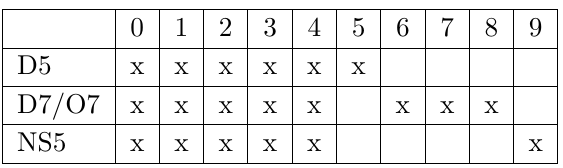
Table 2 . Brane intersection associated to the Abelian T-dual of BO. In the near brane limit x 6 and x 9 mix [11], to produce D7/O7 branes spanned on AdS 6 (cid:2) S 2 and NS5-branes spanned on AdS 6 , consistently with the isometries of the background. These branes are located at (cid:18) = (cid:25)= 2 and (cid:18) = 0,